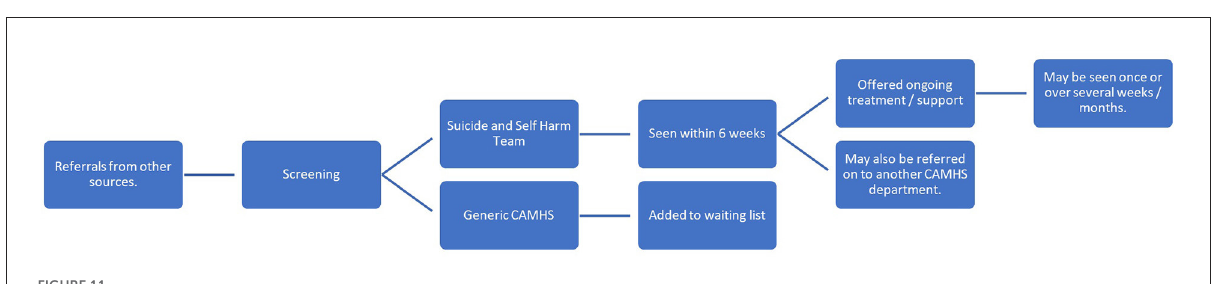
FIGURE11 Referral pathway for children referred from other sources (Site